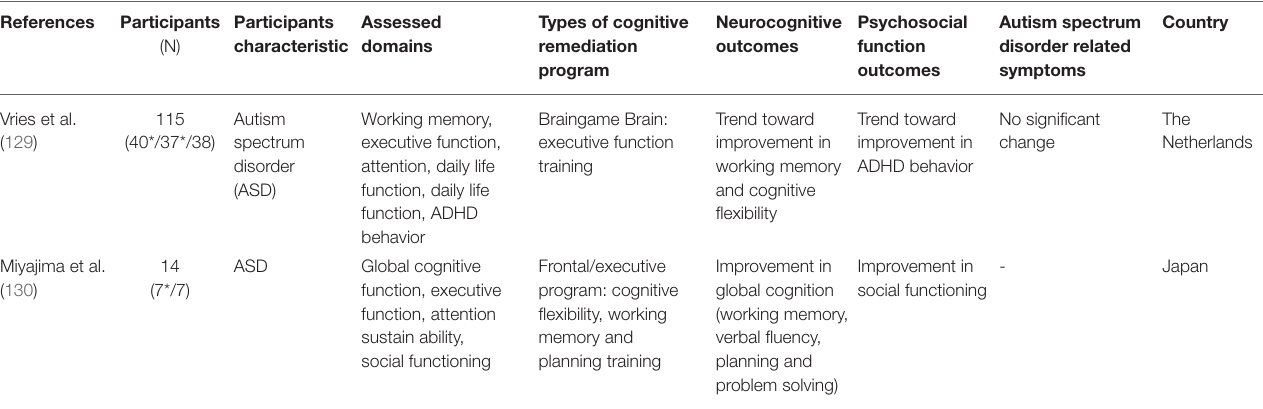
TABLE 7 | RCT studies on CR effect on autism spectrum